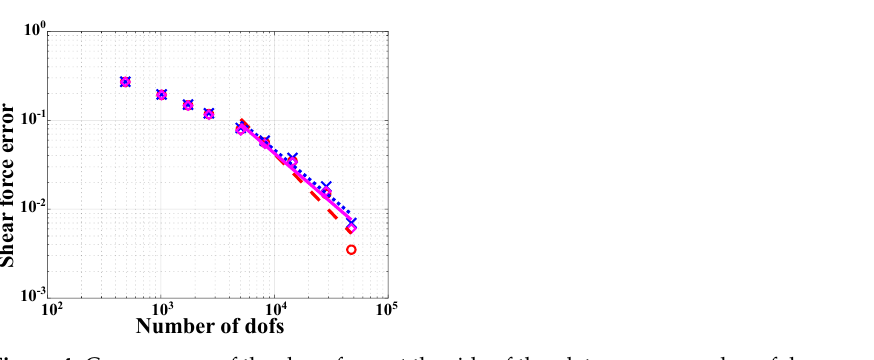
Figure 4. Convergence of the shear force at the side of the plate versus number of degrees of freedom. ¯ a = 533: dashed line ( ◦ ); ¯ a = 53.3: dotted line ( × ); ¯ a = 16: solid line ( (cid:5)